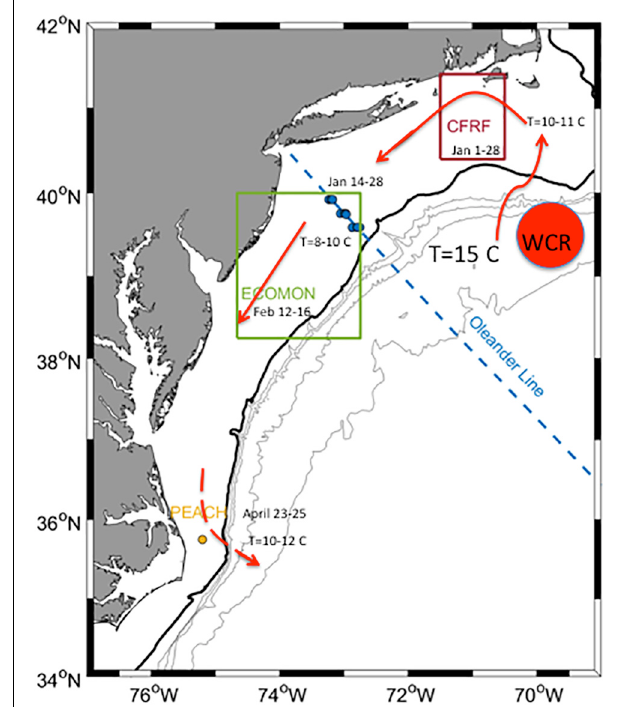
FIGURE 11 | A schematic diagram of the Marine Heatwave from January–April 2017 extending through the entire Middle Atlantic Bight. The date of passage is indicated along with the temperature values as it advects through the region. The dotted arrow near Cape Hatteras indicates that the feature was no longer a Marine Heatwave but retained a distinct salinity anomaly with salinity greater than 34.0